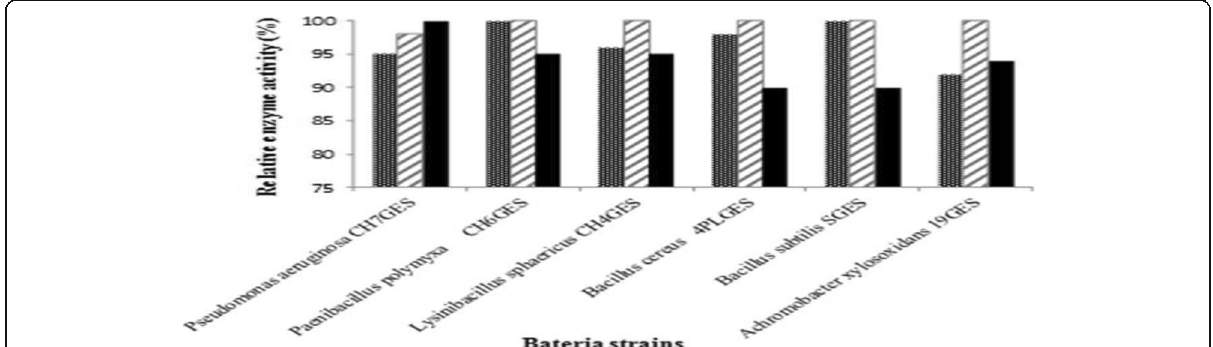
Fig. 1 Enzymes activity of the tested bacterial strains: chitinase (first column), chitosanase (middle column), and protease (third column) activities. The highest values of enzymes activities were set as